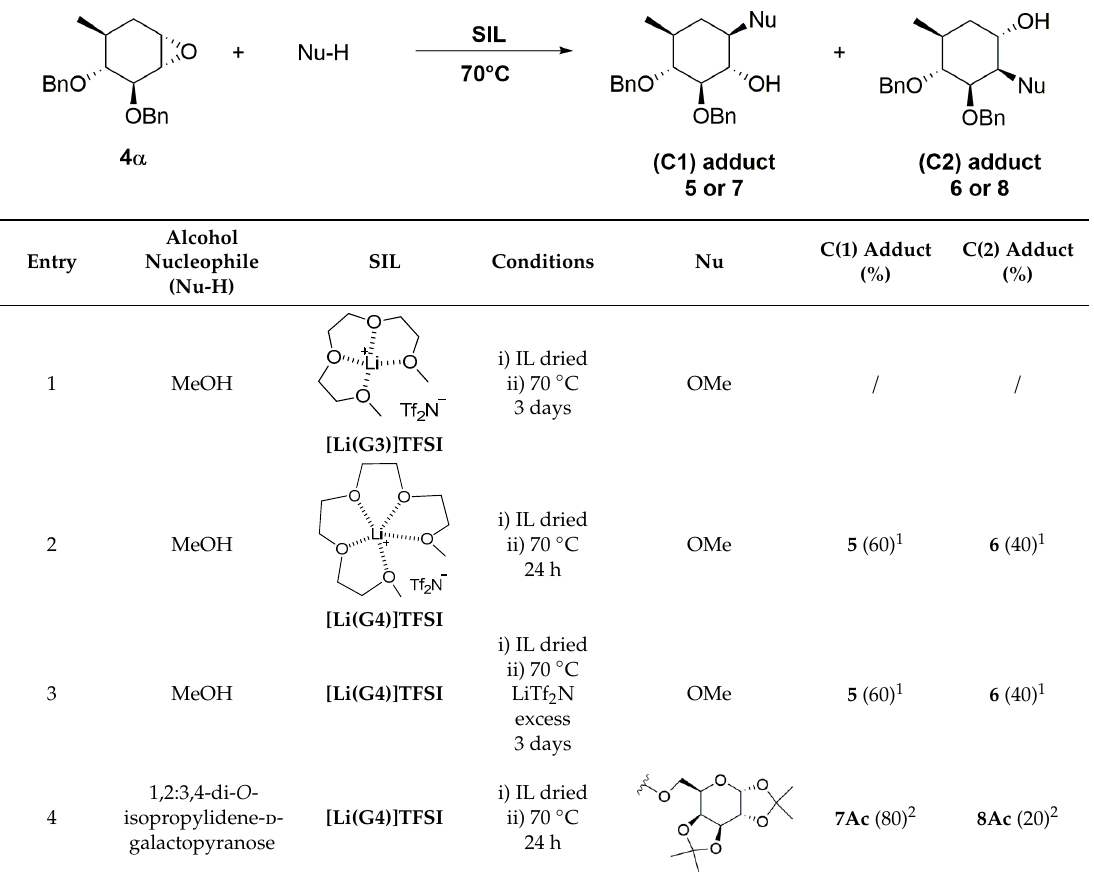
Table 2. Results for the ring-opening addition of alcohol nucleophiles to epoxide 4 α in various SILs and different conditions.